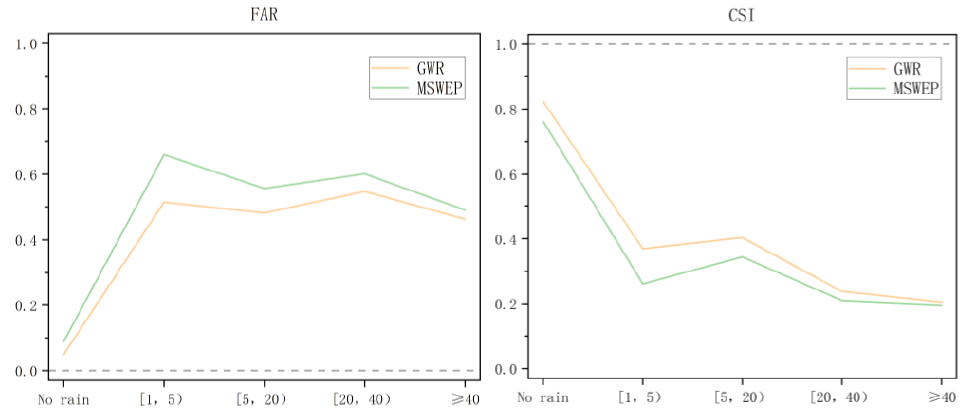
Figure 13. Evaluation statistics for the categorical indices at five precipitation intensity classes (mm/d). From left to right and top to bottom: POD, FAR, FBI, and CSI. The dashed black line represents the optimal value of each index.